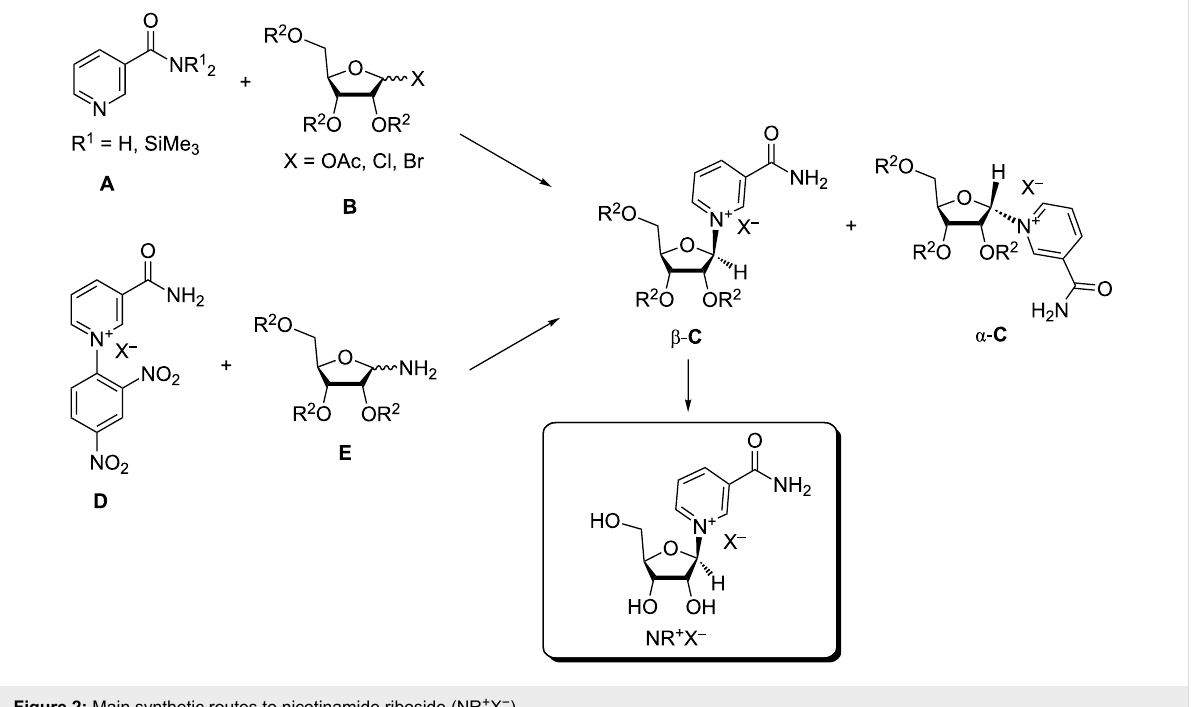
Figure 2: Main synthetic routes to nicotinamide riboside (NR + X −